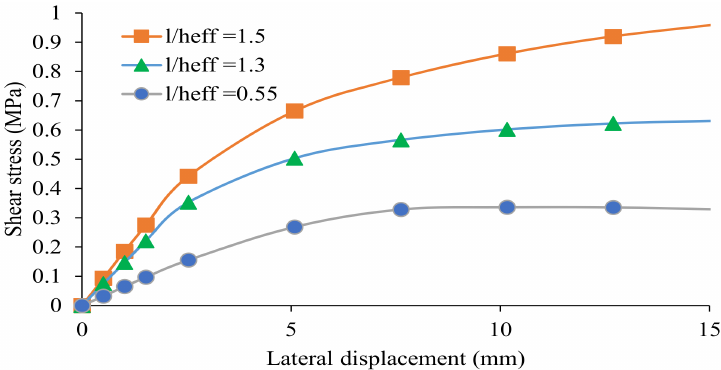
Figure 10. Influence of aspect ratio in shear strength of URM